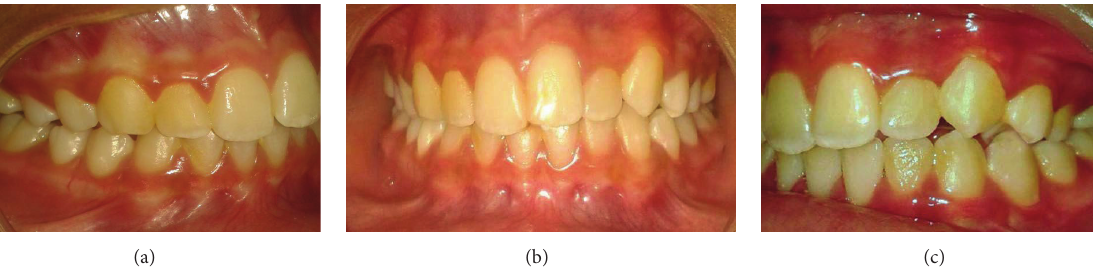
Figure 4: Postoperative condition indicating correction of (a) anterior open bite, (b) posterior crossbite, and (c) alignment of the palatally locked lateral incisor.